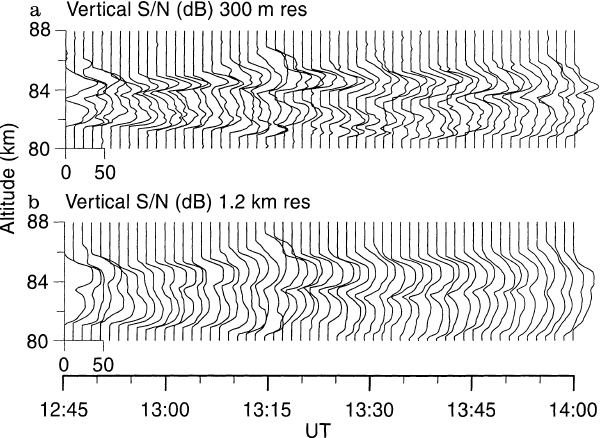
Fig. 4a, b. Altitude profiles of the vertical S/N at a 300-m-altitude resolution and b 1.2-km-altitude resolution on 22